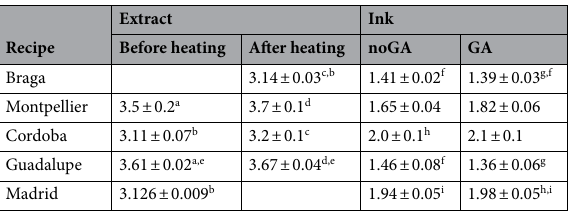
Table 5. pH values of the extracts (before and after heating) and inks (with and without gum arabic) for all recipes produced. All pH values with the same letters are significantly equals (P <